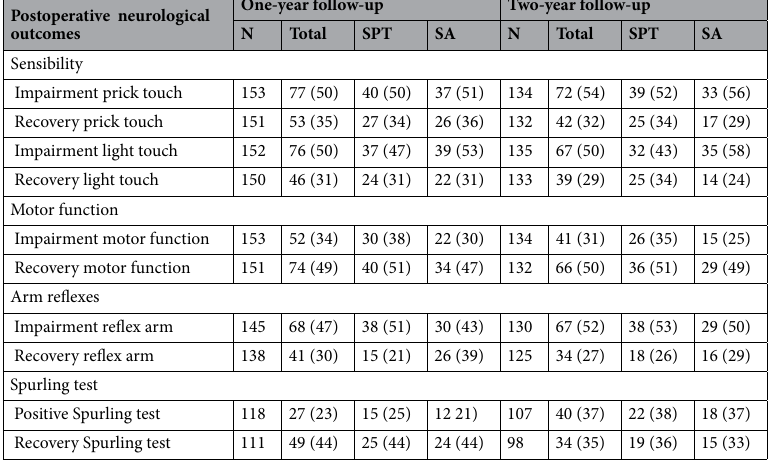
(Table 2). The prevalence of neurological impairments in sensibility, motor function and a positive Spurling test decreased significantly over time in both groups (p < 0.04), whereas neurological impairment in arm reflex was significantly decreased at one year only in the SA group (p = 0.04). Post-hoc tests showed that significant changes in neurological outcomes occurred only at one year follow-up and not in the postoperative period from one to two-year follow-up (p > 0.34).